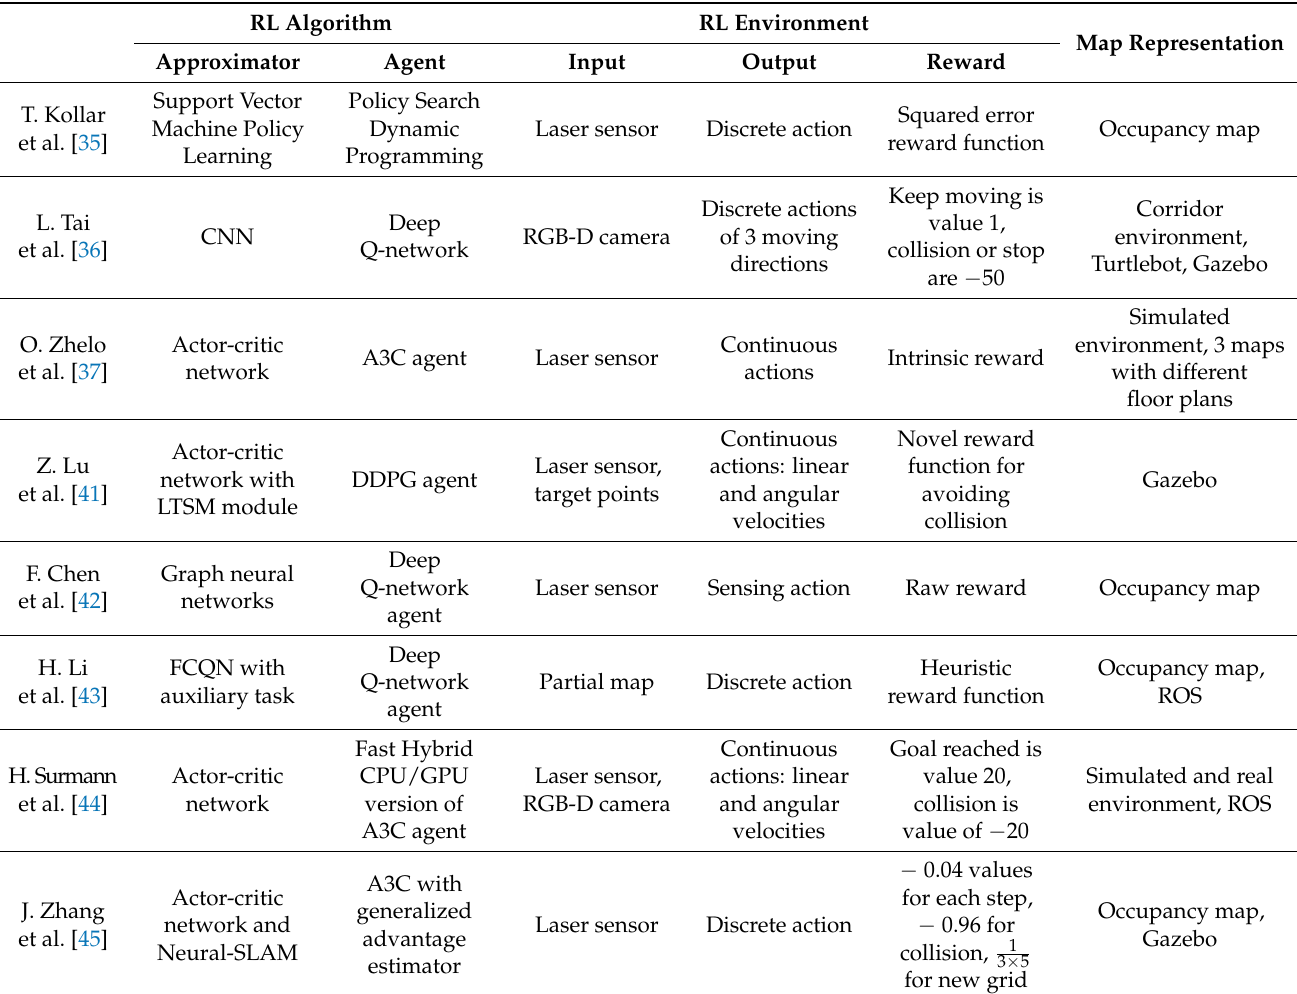
Table 1. Related works on the mobile-robot exploration using